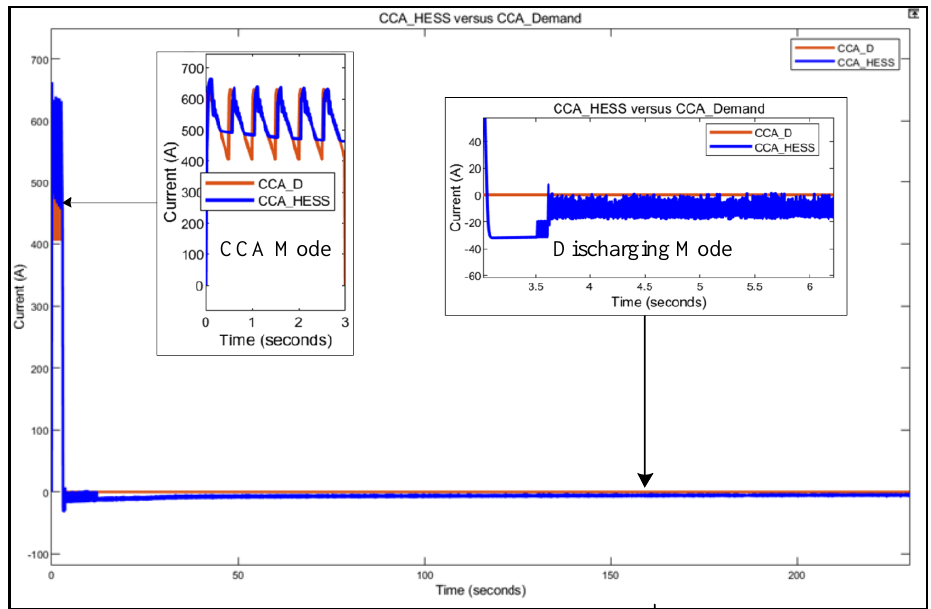
Figure 16. HESS supplying the required CCC for case three (a).